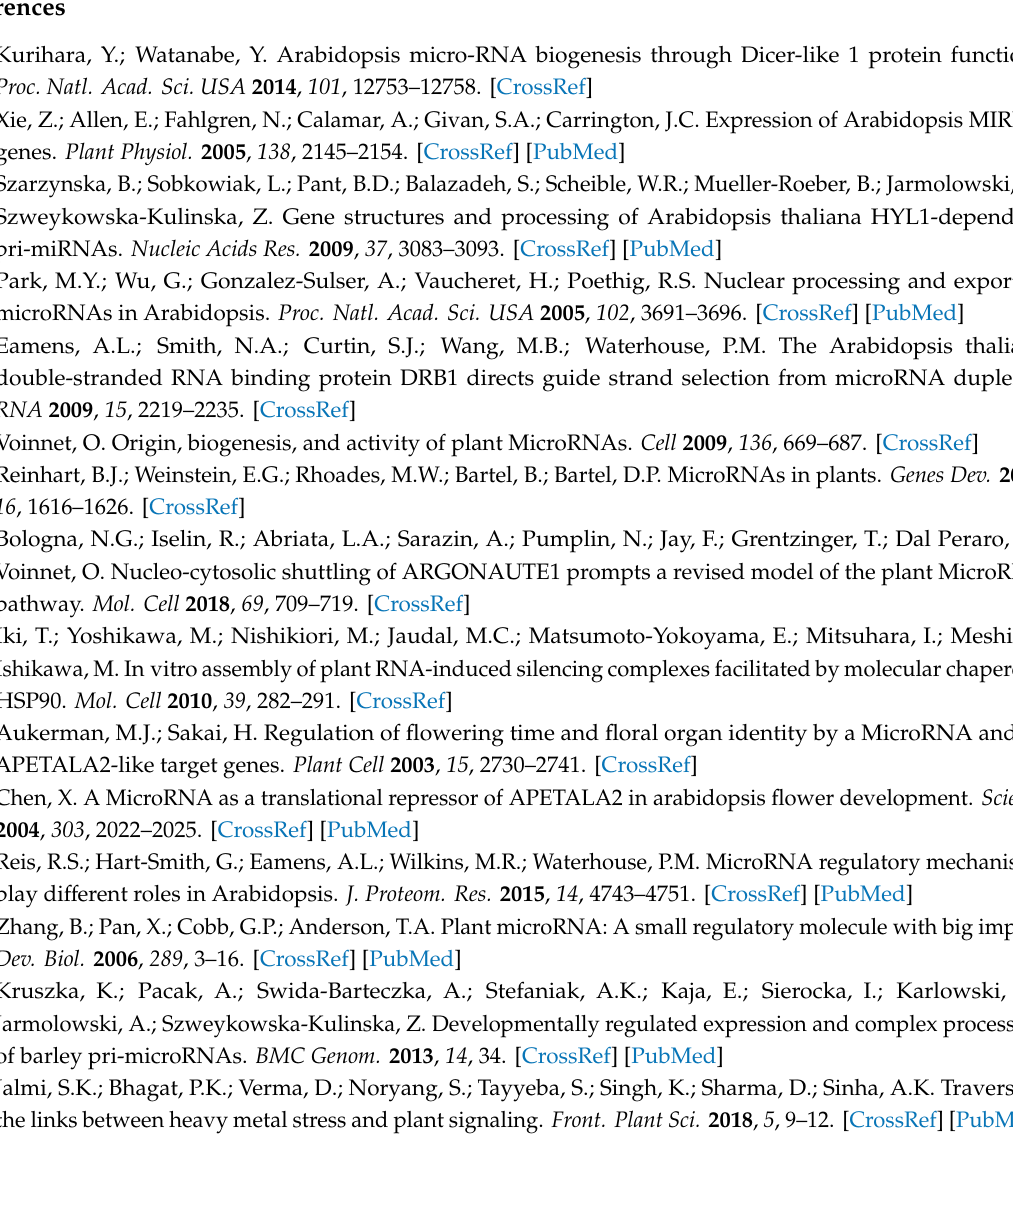
Supplementary Table S1: A list of microRNA* for novel barley microRNAs; Supplementary Table S2: A list of primers used in the study; Supplementary data 3: Sequences of obtained pri-microRNAs; Supplementary data 4: Agarose gel showing amplified pri-microRNAs; Supplementary datasheet 5: NGS data calculation of novel microRNAs in developmental stages of barley; Supplementary datasheet 6: Calculation of expression of mature microRNAs in particular organs of barley flower; Supplementary data 7: Northern hybridization of microRNAs in drought conditions; Supplementary datasheet 8: NGS data calculation of novel microRNAs in drought stress conditions; Supplementary datasheet 9: Calculation of expression of novel microRNAs targets in drought conditions with primers flanking cleavage